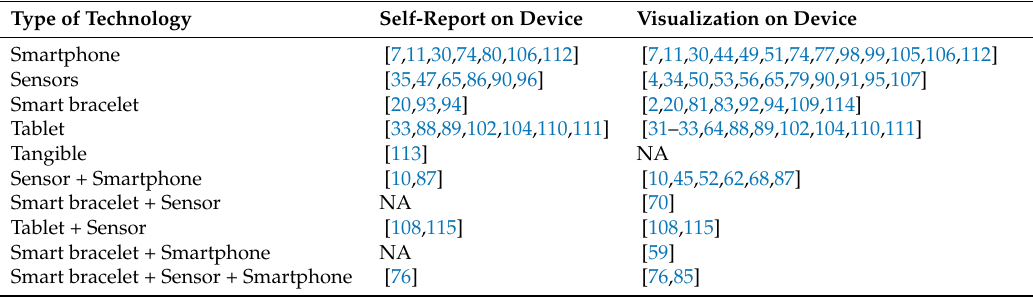
Table 5. The outcome of technology types, grouped by self-reporting and data visualization.